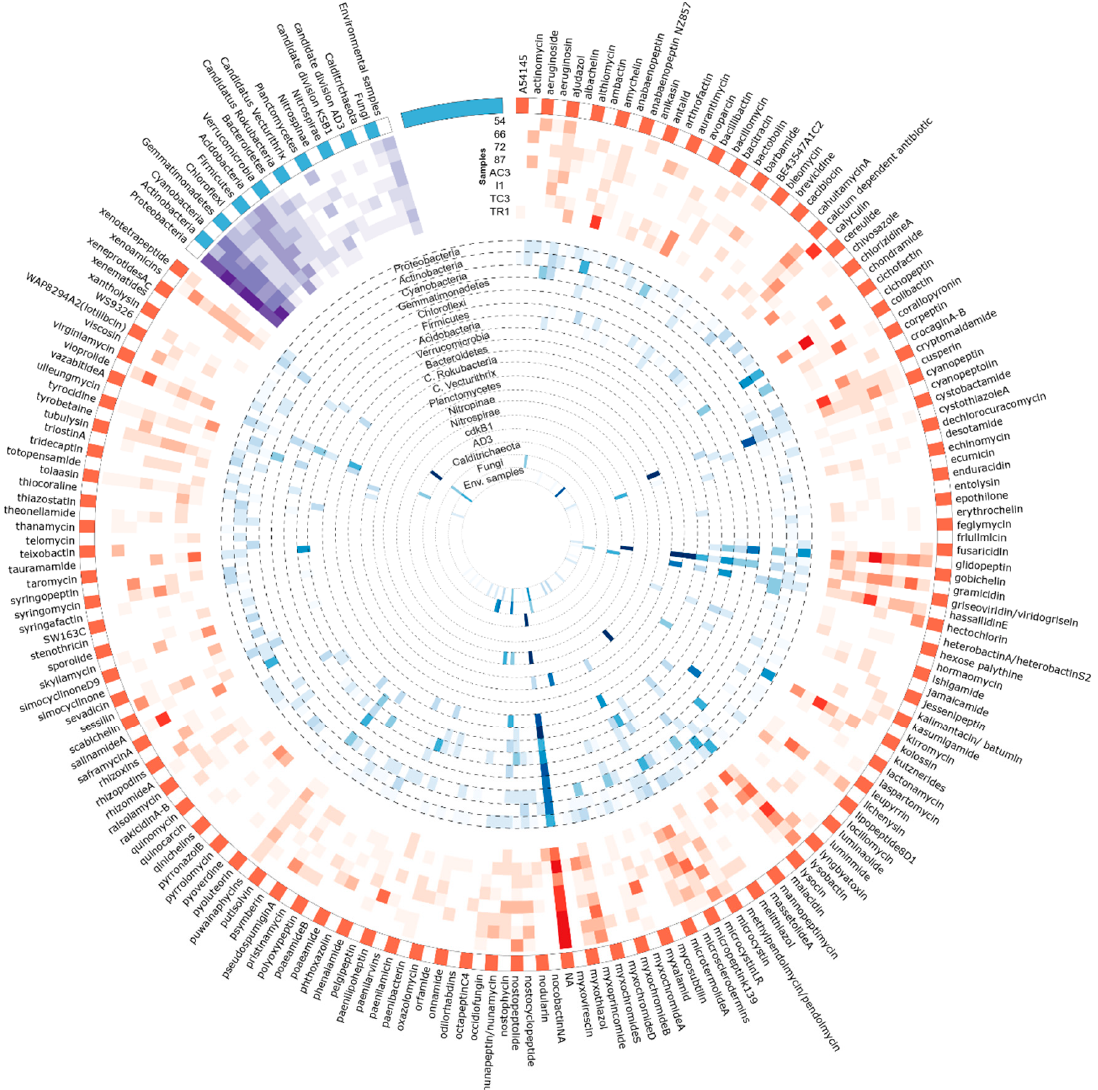
Figure 9. Circular visualization of the distribution of AD domain OTUs identified against MiBIG database and its correspondent taxonomical provenience. Figure produced using circos software [45]. Read the figure clockwise, from the outside to the interior. The outside represents the metabolites assigned to the KS domain sequences by using the MiBIG database (orange and white). Heatmaps represent the sum of the metabolites assigned to the AD domain sequences for each sample (in red) and the relative abundance of its correspondent taxonomic provenience for each phylum (in blue). A third heatmap (in purple) represents the total number of metabolites from KS domain with taxonomic provenience of each phyla per sample.